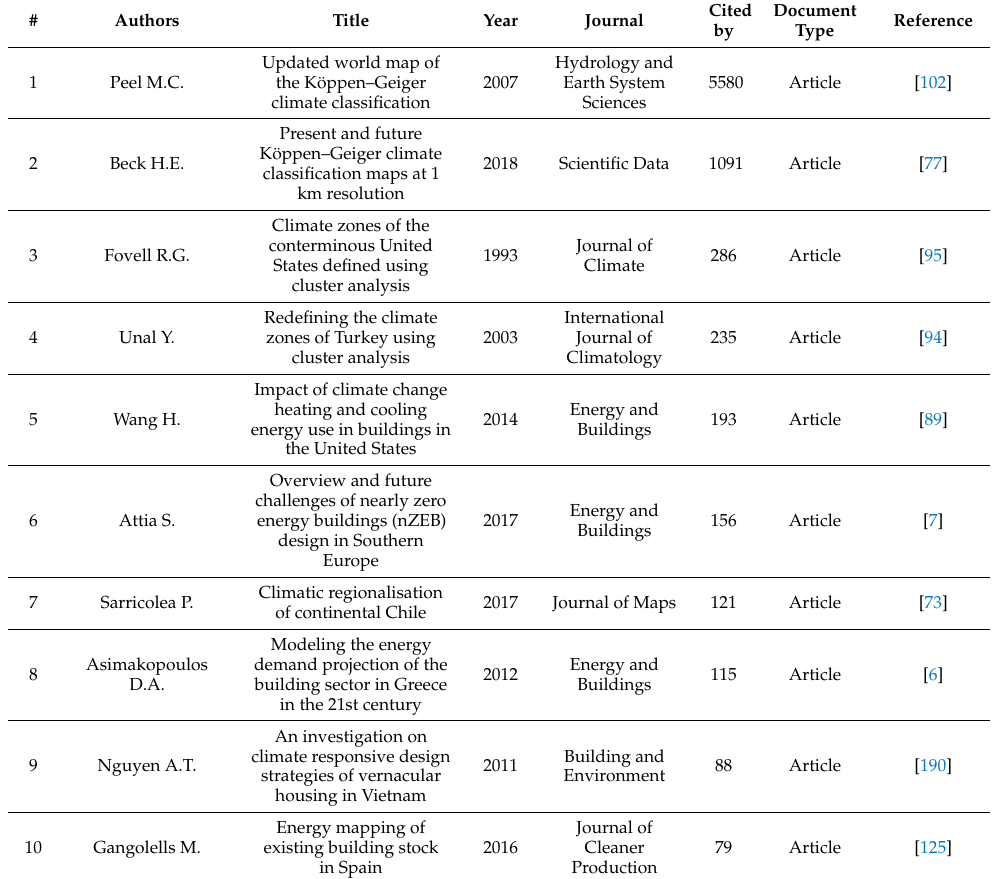
Table 5. The most-cited publications in the